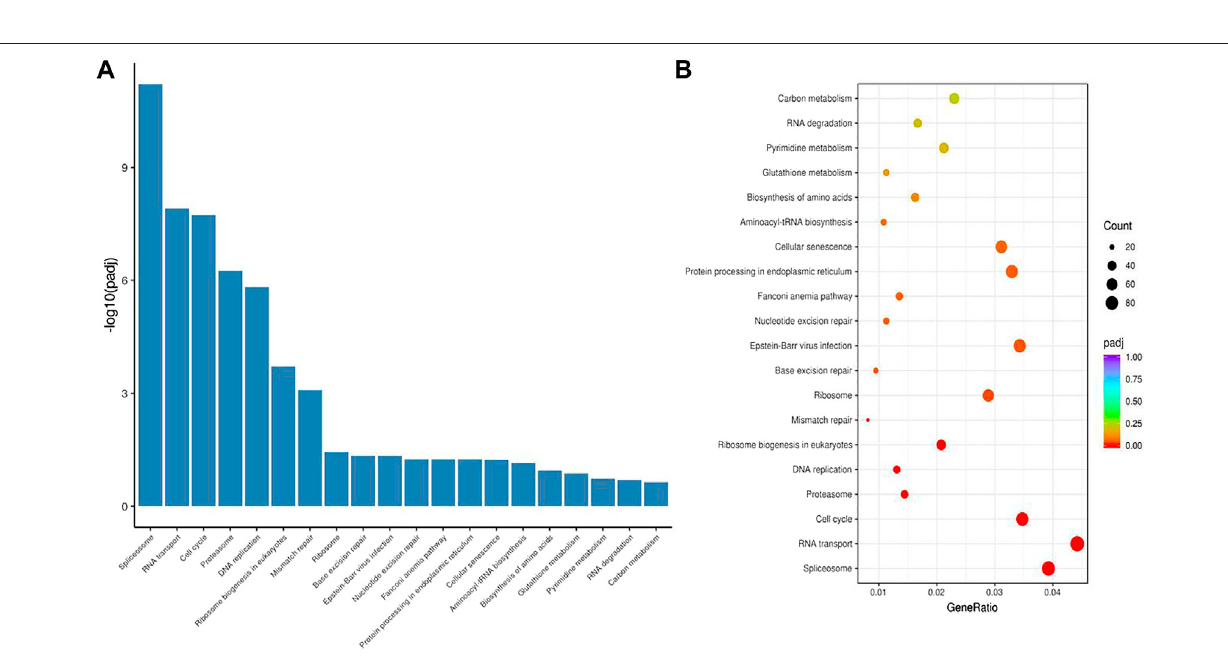
Frontiers in Genetics |